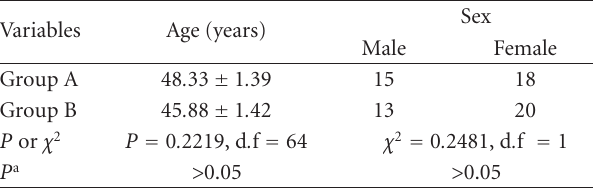
Table 1: Demographic characteristics of patients with type 2 diabetes mellitus.